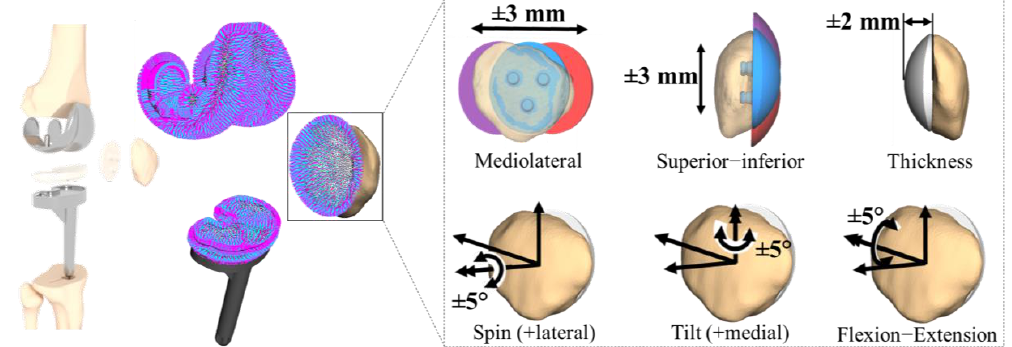
Figure 3. In silico study on the effect of the patellar component designs and positionings. Mediolateral positioning of patellar component ±3 mm, superior–inferior positioning of patellar component ±3 mm, and patellar button design parameter by increasing/decreasing the thickness of the patellar component ± 2 mm. The rotational positioning was analyzed by the spin of the patellar component ± 5 ◦ , tilt of the patellar component ± 5 ◦ , and flexion-extension of patellar component ± 5 ◦